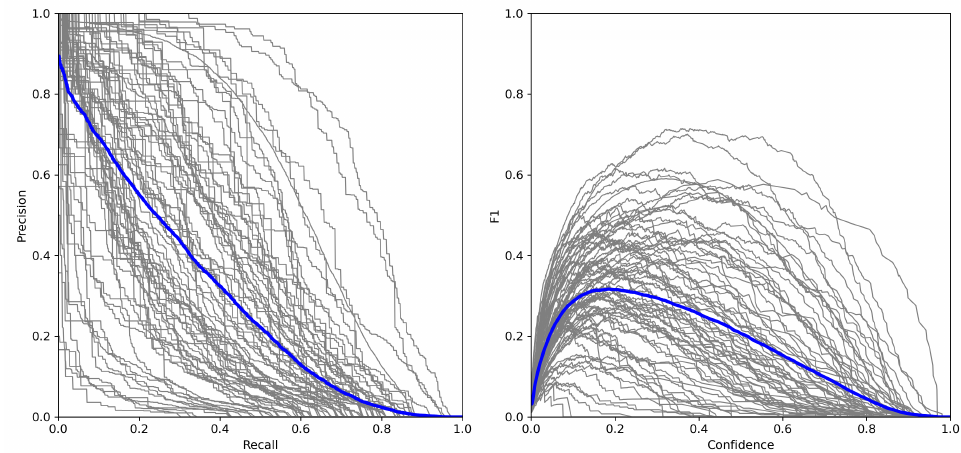
Figure 4. Curves of precision-recall and F1-score during the search process. The supernet is trained for 30 epochs. Blue line denotes the averaged value among all 80